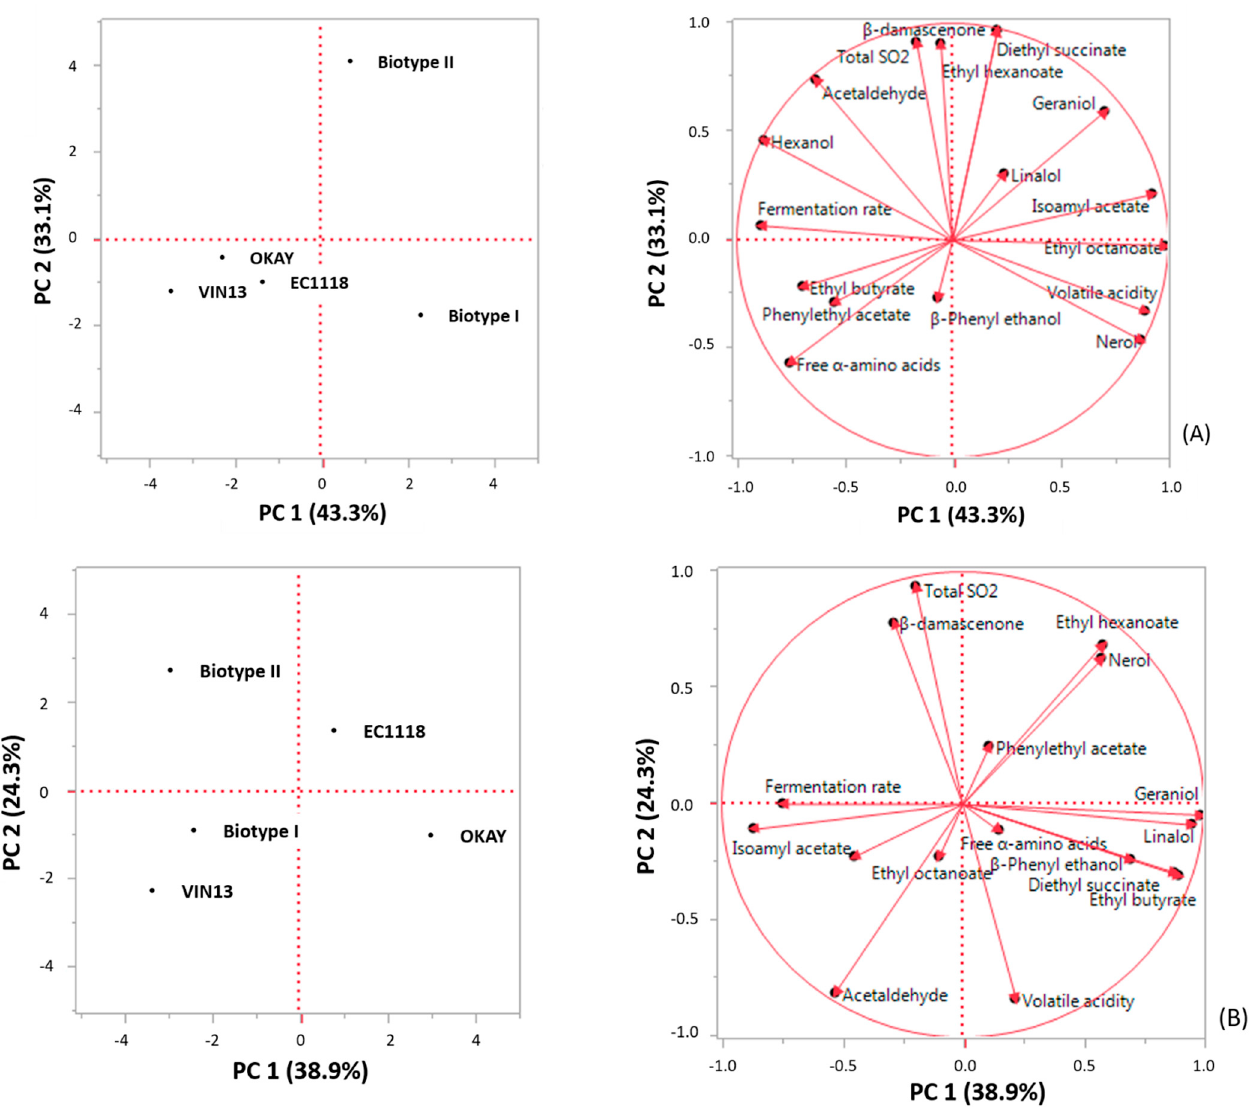
Figure 2. Principal Component Analyses (PCA) for the main analytical characteristics and volatile compounds of wines obtained by two biotypes at 16 ◦ C ( A ) and 22 ◦ C ( B ) Fermentation